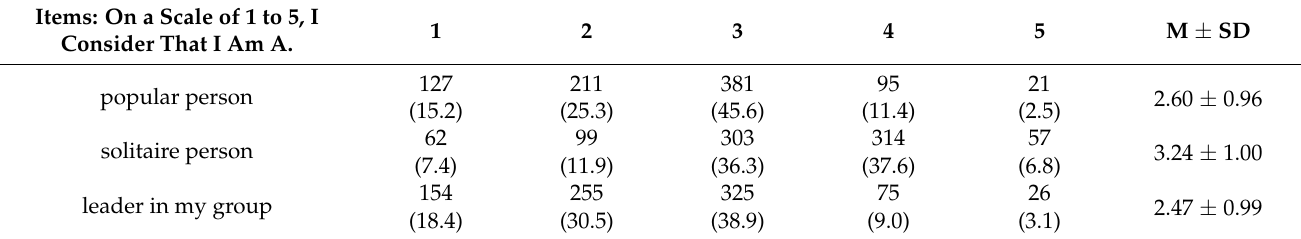
Table 3. Self-rated items regarding agreement with different items 1